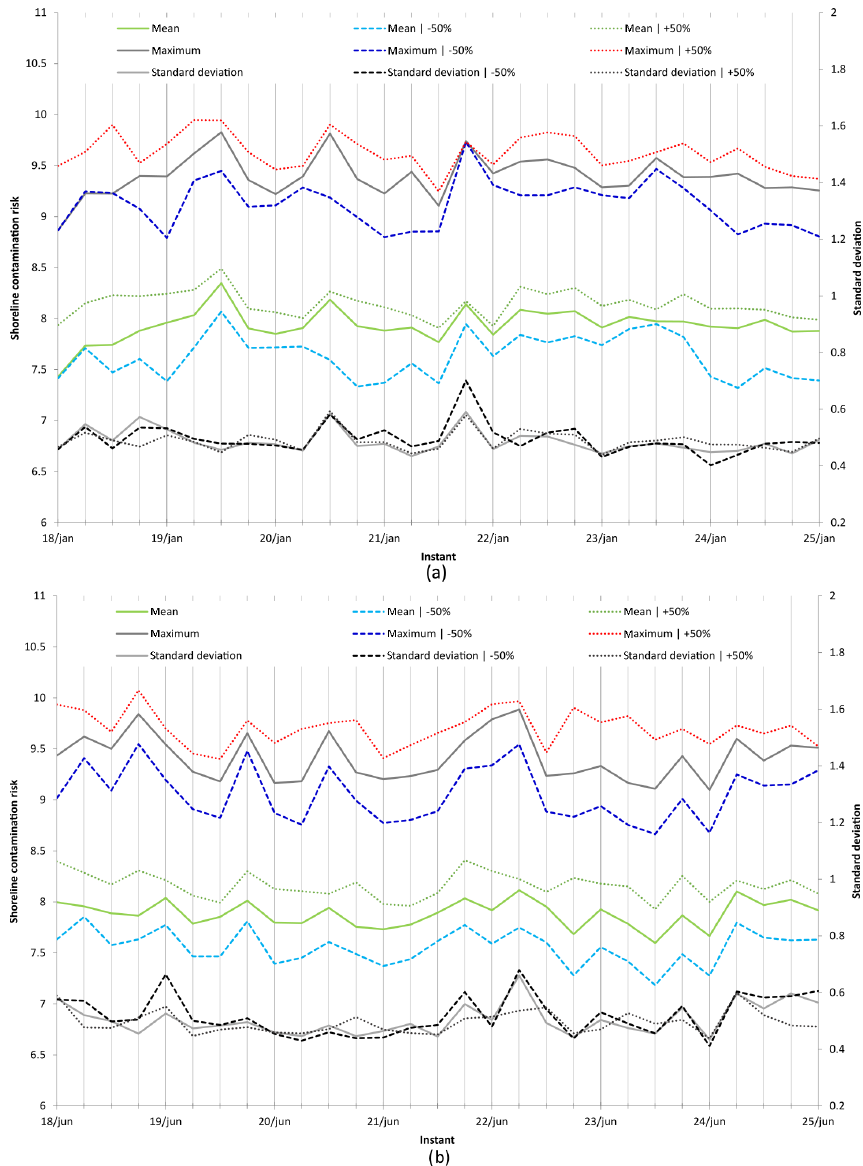
Figure 13. Integrated shoreline contamination risks (instant mean, maximum and standard deviation) for the whole pilot area, obtained with three values for metocean model parameters (direct model output; model + 50%; model – 50%). AIS vessel information and metocean model conditions between 18 and 25 January 2013 (a) , and with AIS vessel information and metocean model conditions between 18 and 25 January 2013 (b)